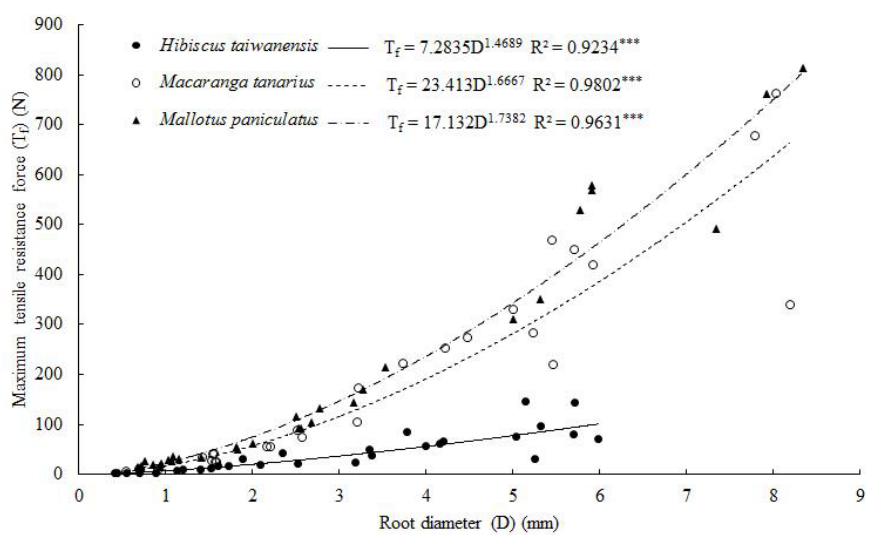
Figure 4. Relationship between root tensile resistance force and root diameter for the three studied species fitted to a power law function.